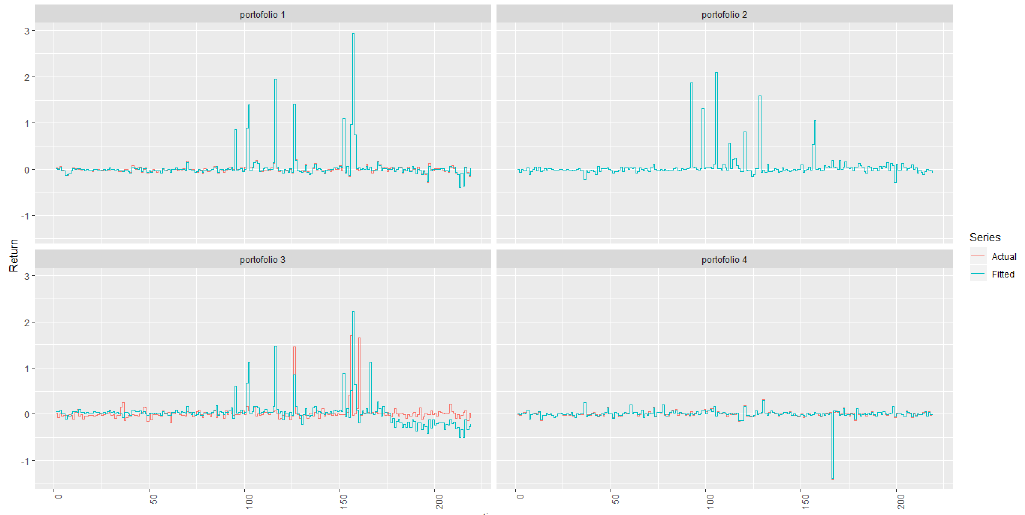
Figure 2. Actual and predicted returns after the two-factor model. Source: author’s computation.